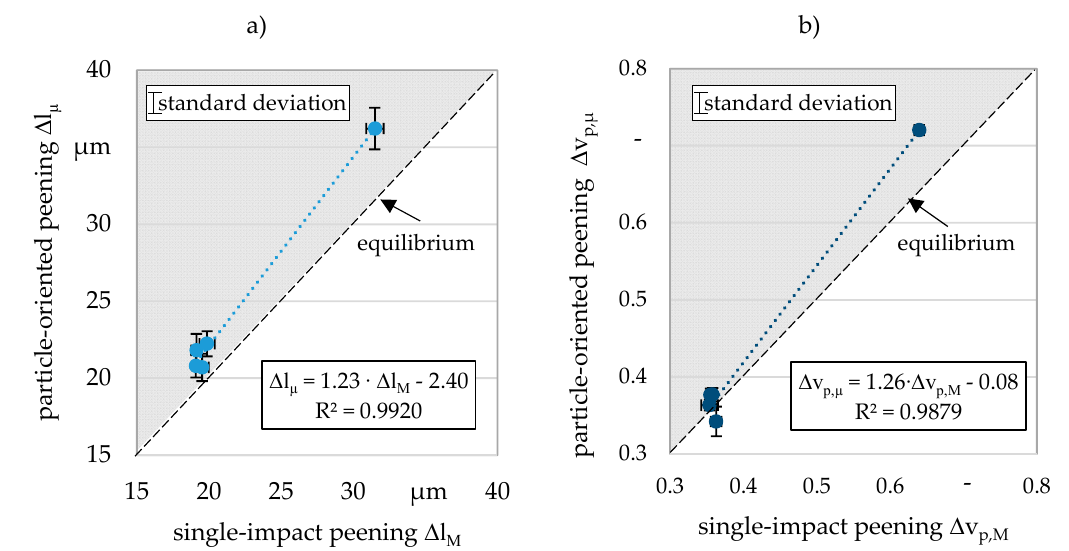
Figure 8. Determination of the functional scaling relationships ( a ) linear plastic deformation, ( b ) velocity reduction.